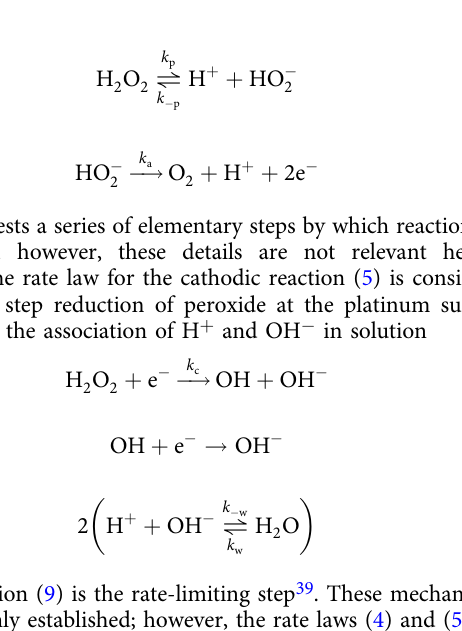
8.6 μ m s − 1 for the experimental conditions. d Computed angular velocity Ω as a function of the asymmetry parameter c for spinners with n = 2 – 6 fi